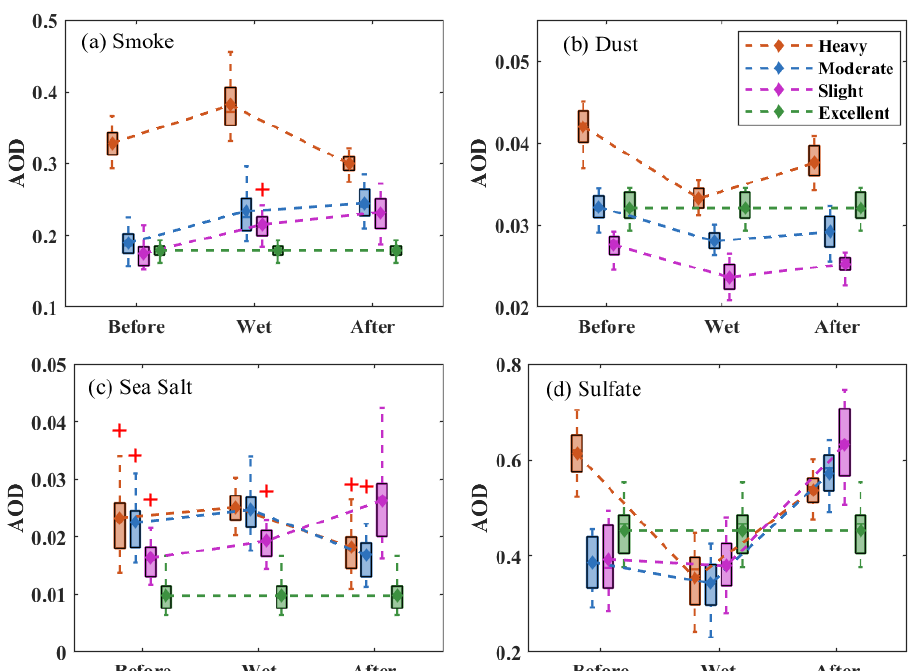
Figure 9. The AOD of ( a ) smoke, ( b ) dust, ( c ) sea salt, and ( d ) sulfate under different stages and levels. The diamond represents the average values of AOD. The horizontal lines inside the boxes are the medians, and the bottom and top sides of the boxes represent the first and third quartiles. The whiskers are the minimum (maximum) values within 1.5 interquartile ranges of the lower (upper) quartile. The red plus symbol represents the aberrant points with high values.